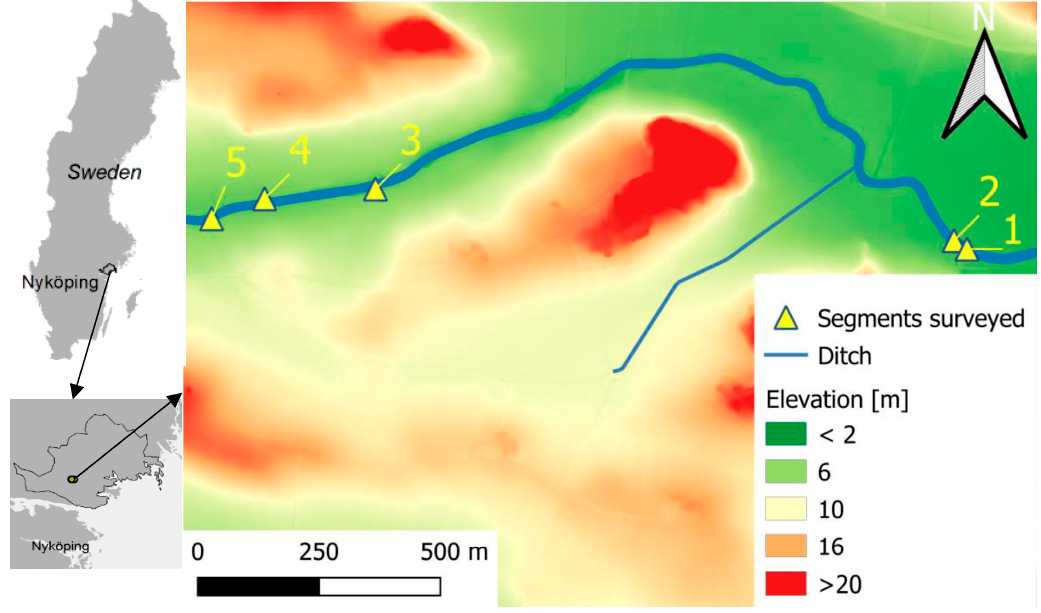
Figure 1. Location of the study site in Sweden and of ditch segments examined in this study. Each point (1–5) represents the approximate mid-point of each of the five 10–15 m long segments investigated. Elevation data from ©Lantmäteriet [23].